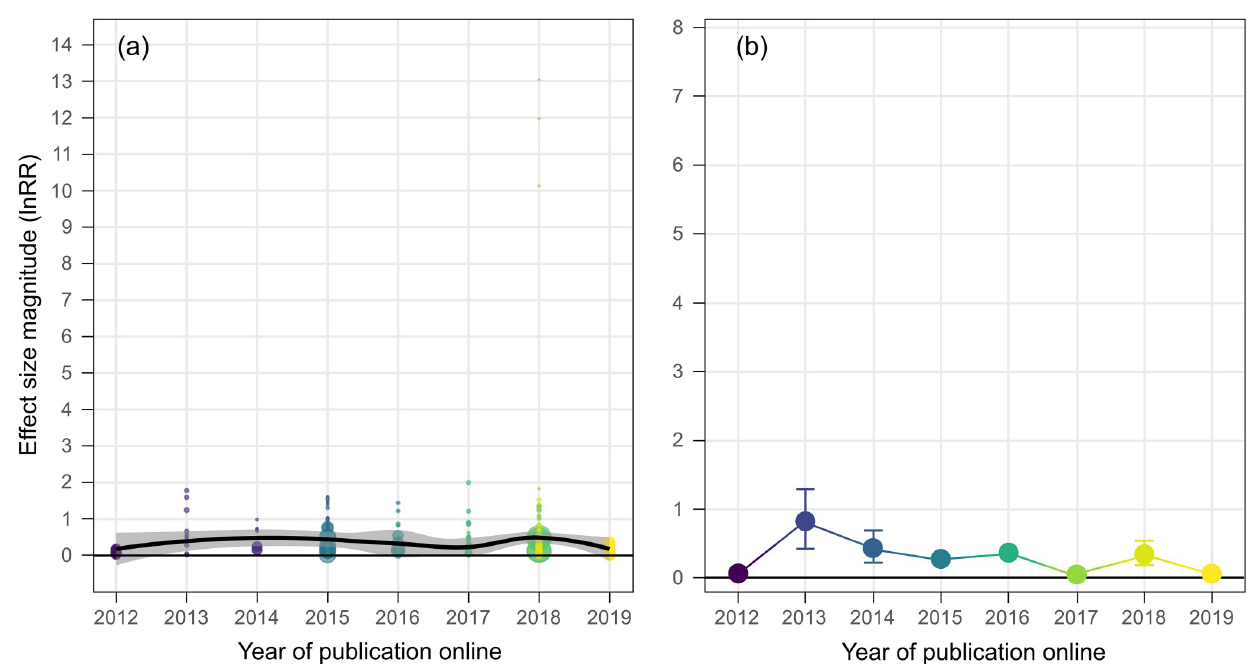
Fig 5. The decline effect in ocean acidification research on fish behavior excluding studies authored (or coauthored) by lead investigators of initial studies. (a) Trend in raw effect size magnitudes (absolute lnRR) for each experiment in our dataset excluding all studies authored (or coauthored) by lead investigators of the 3 initial studies [8–10] plotted as a function of year of publication online and color coded according to study. Data are fit with a Loess curve with 95% confidence bounds. (b) Mean effect size magnitude (absolute lnRR ± upper and lower confidence bounds) for each year of publication online in our dataset excluding all studies authored (or coauthored) by lead investigators of the 3 initial studies. Mean effect size magnitudes and confidence bounds were estimated using Bayesian simulations and a folded normal distribution. Note: Colors in (b) are aesthetic in nature and follow a gradient according to year of publication. Also note that data begin in 2012 since all publications prior to 2012 included initial lead investigators in the author list. Vertical axes are scaled to enable direct comparison with Fig 1. Source data for each figure panel can be found in S1 Data.